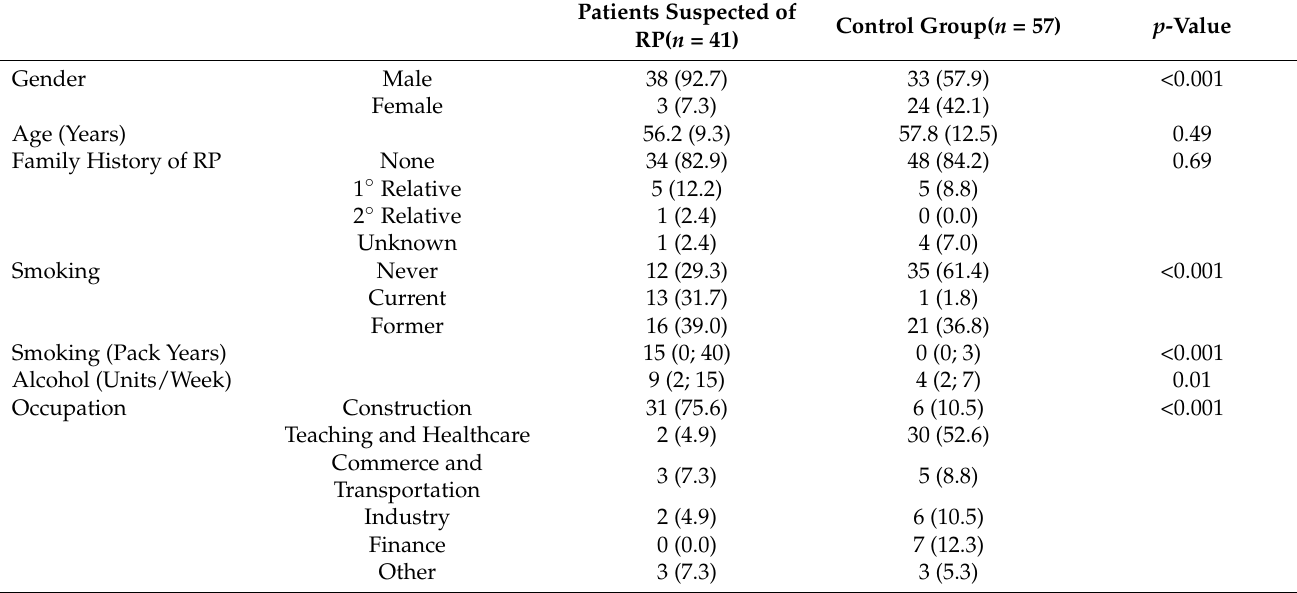
Table 2. Clinical characteristics of the participants. Data are presented as number (%), mean (SD), or median (IQR). Raynaud’s phenomenon